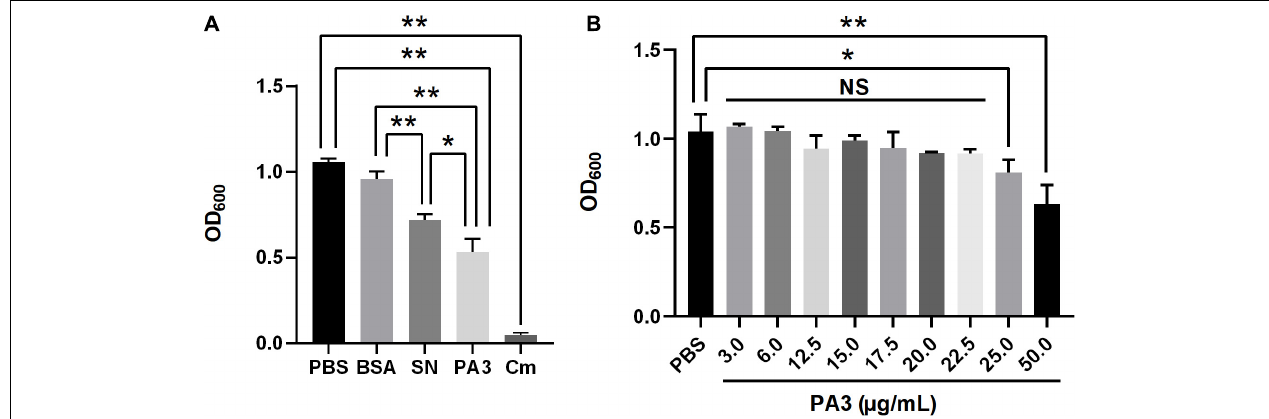
FIGURE 5 | Characterization of peptide aptamer PA3. (A) Antibacterial activity of PA3 against Aeromonas veronii. Each of phosphate buffered saline (PBS), bovine serum albumin (BSA), SN, PA3, or Cm was added to the bacterial cultures, and OD 600 measurements were carried out after 10 h of incubation. (B) Susceptibility test of PA3 in A. veronii . The serial concentrations of PA3 were diluted for supplementation in the bacterial cultures, and OD 600 measurements were carried out after 10 h of incubation. The “NS” represents “not statistically significant” and “*,**” are significant ( p < 0.05) and extremely significant differences ( p < 0.01),